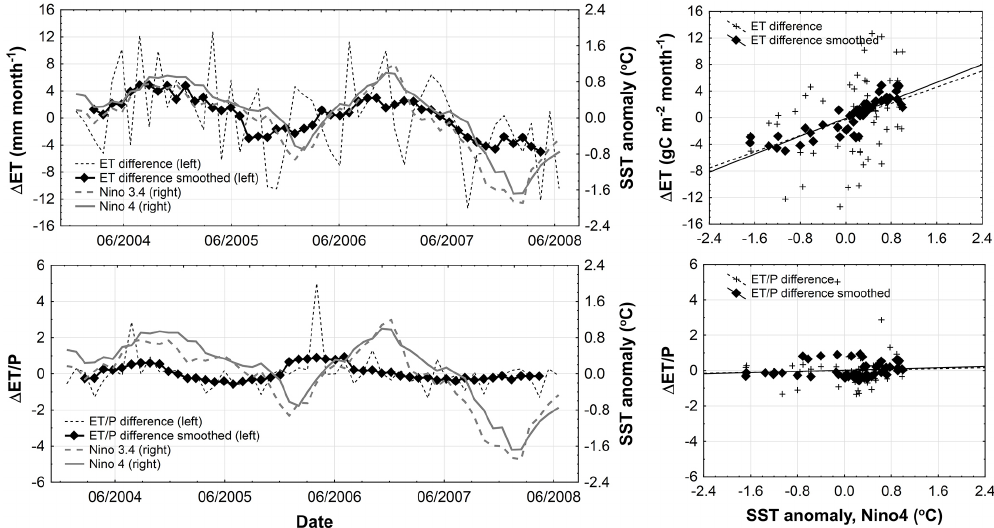
Figure 7. Comparisons of interannual patterns of SST anomalies in Nino4 and Nino3.4 zones of the equatorial Pacific with variability in both deviations and 7-month ( ± 3 months) moving average deviations of monthly ET rate and ratio ET /P from mean monthly ET rate and ET /P averaged over the entire measuring period from 2004 to